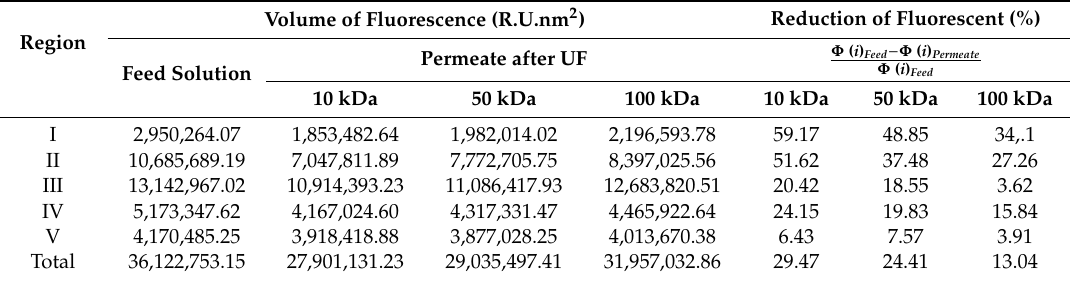
Table 7. Volume of fluorescence Φ ( i ) and the reduction in the concentration of fluorescent compounds after ultrafiltration (UF). Volume of Fluorescence (R.U.nm 2 ) Reduction of Fluorescent (%) Region Permeate after Feed Solution